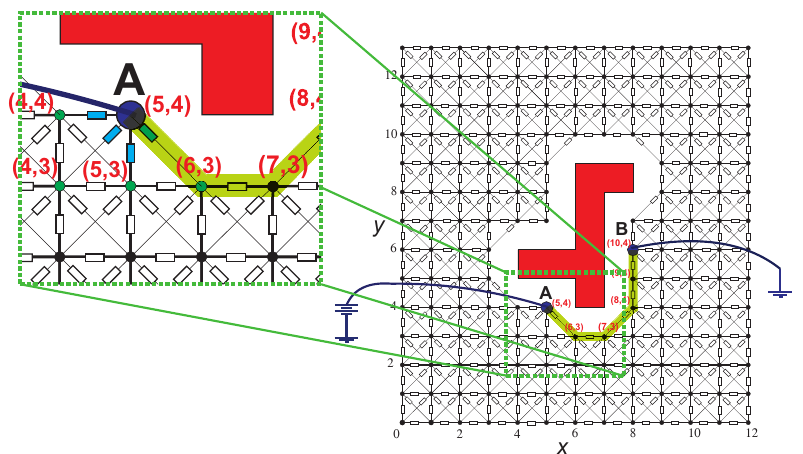
Figure 4. Local current comparison